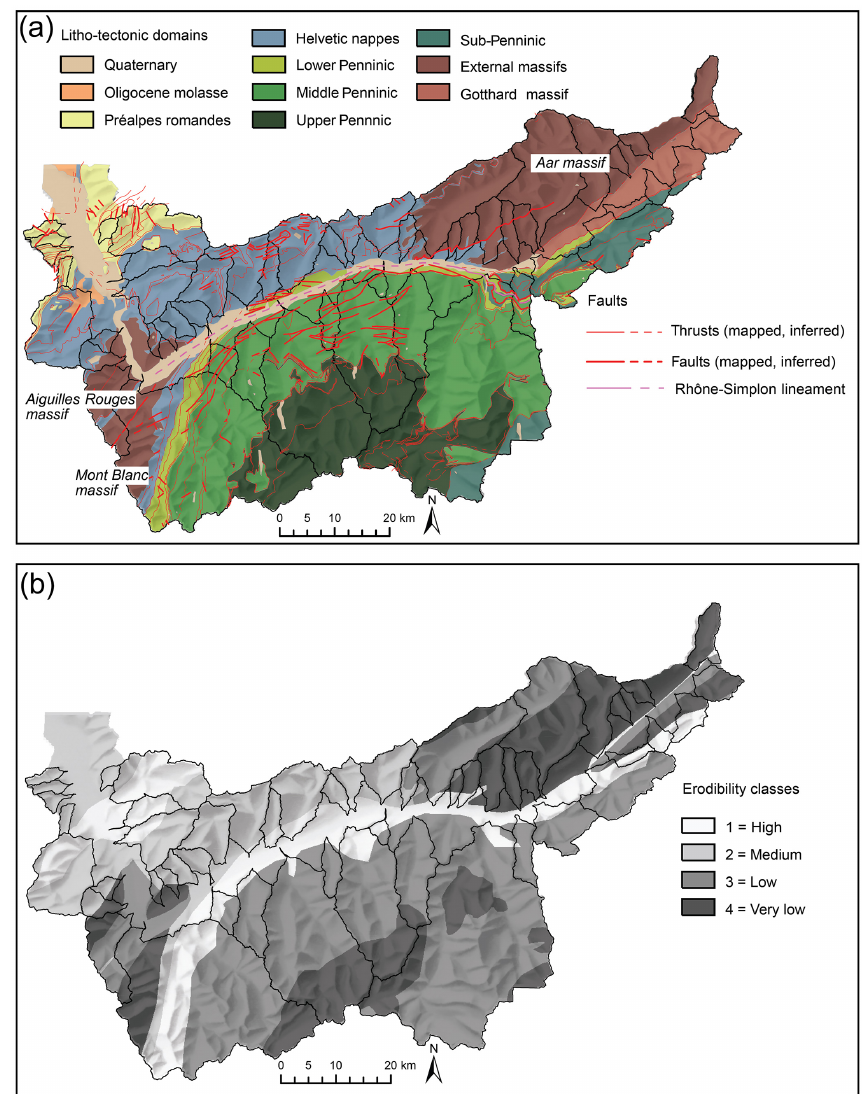
Figure 2. Panel (a) : simplified litho-tectonic map of the study area showing the major paleogeographic domains, the Helvetic nappes (blue), the Penninic nappes (green) and the external massifs (red) and the major structural features (data compilation from swisstopo © geological map 1:500000). Panel (b) : erodibility map after Kühni and Pfiffner (2001), based on Niggli and de Quervain (1936) and Jäckli (1957) showing the general erodibility of